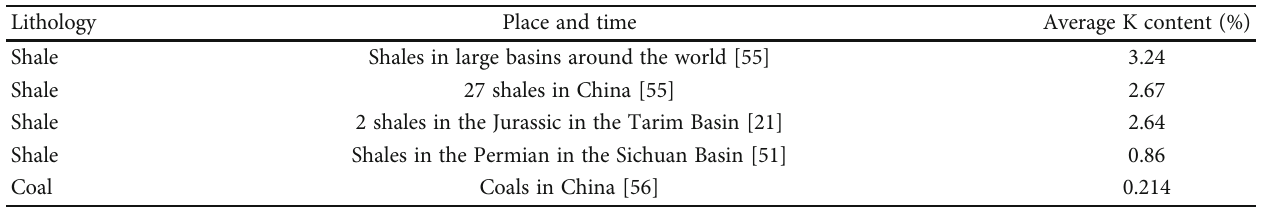
Figure 11: Burial and thermal histories of the Longtan Formation in the study area in west Guizhou: (a) YV-1 and (b) HV-3. The results show that the Ro values of YV-1 and HV-3 reached above 1.0% during the Late Triassic, and the forecasted Ro values match the measured Ro values at the YV-1 and HV-3 wells. Table 5: Potassium contents of coals and